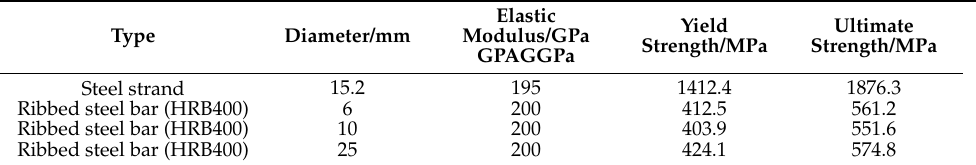
Figure 1. Dimensions and reinforcement of test beams (unit: mm). Table 1. Mechanical parameters of steel strands and ordinary steel bars.